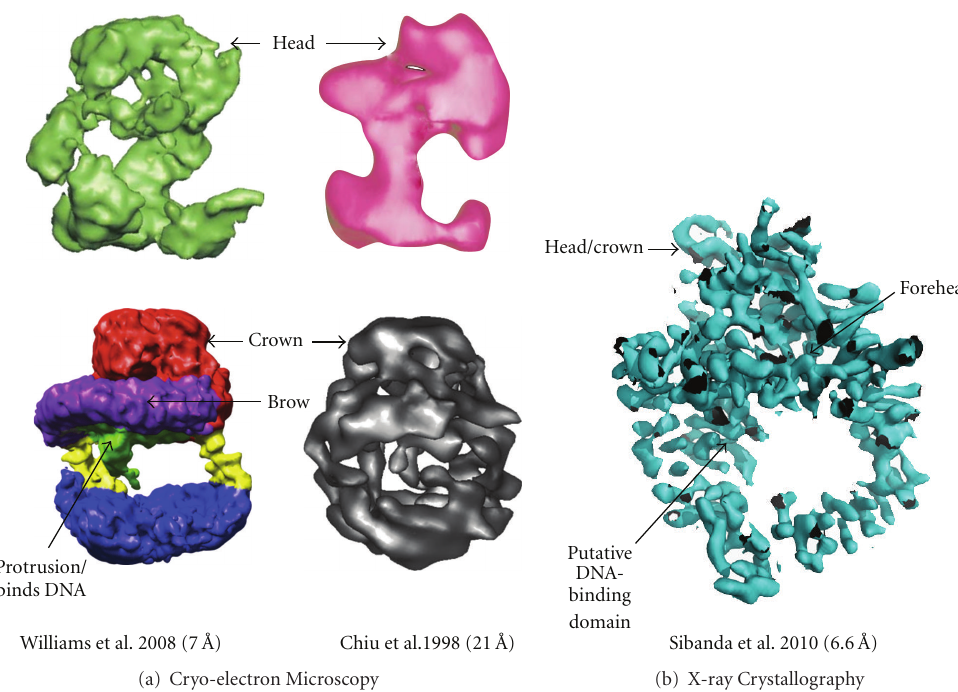
Figure 4: Equivalent views of DNA-PKcs as defined by (a) Cryo-electron microscopy and (b) X-ray protein crystallography. References to the publications and resolutions of the models are given above. Colour coding of these EM structures are as given in their respective publications [44–47]. The X-ray crystallographic experimental electron density map is as defined by Sibanda et al.